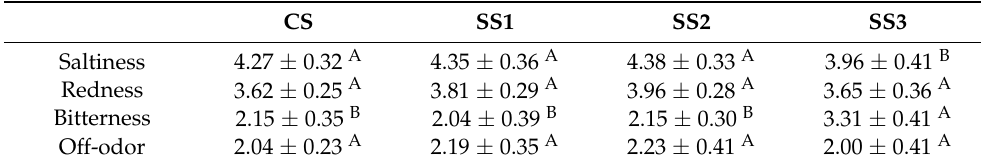
Table 2. Influence of the partial replacements of NaCl by KCl on the sensory qualities of